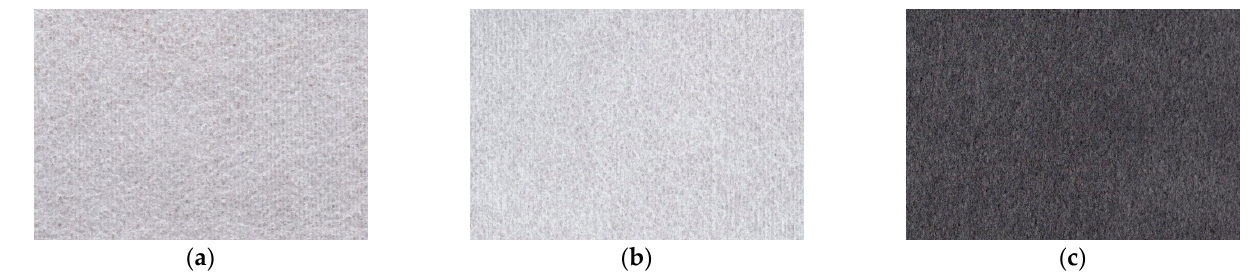
Figure 8. SEM images of composites with various GE content in coating agent, with ( a ) 0, ( b ) 5, ( c ) 10, ( d ) 15, ( e ) 20, and ( f ) 25 g/L.